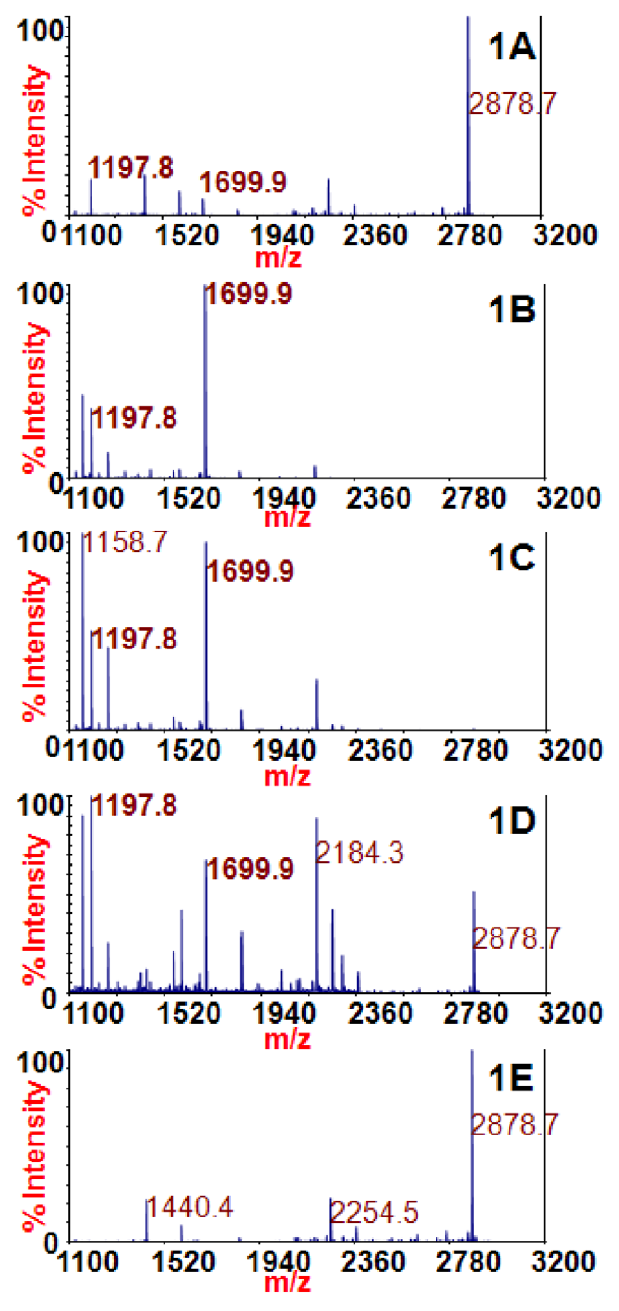
Figure 1. Mass spectra of the Endopep-MS BoNT/A reactions with /A1 (1A), /A2 (1B), /A3 (1C), /A4 (1D), or no toxin (1E) extracted using the 4E17.1 antibody-coated beads. The peptide cleavage products indicating BoNT/A are m/z 1197.8 and 1699.9; the peptide substrate is present at m/z 2878.7.